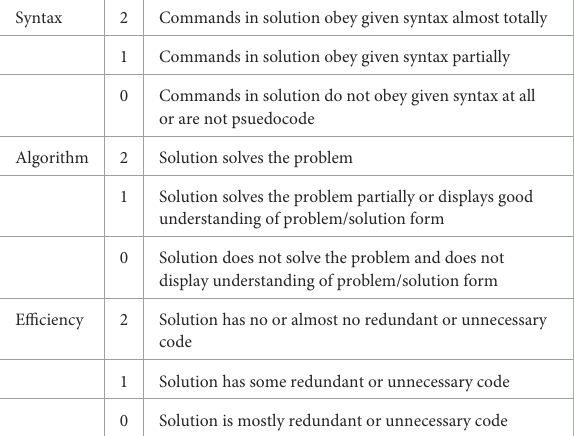
TABLE 1 Rubric used to evaluate student responses on pretest and